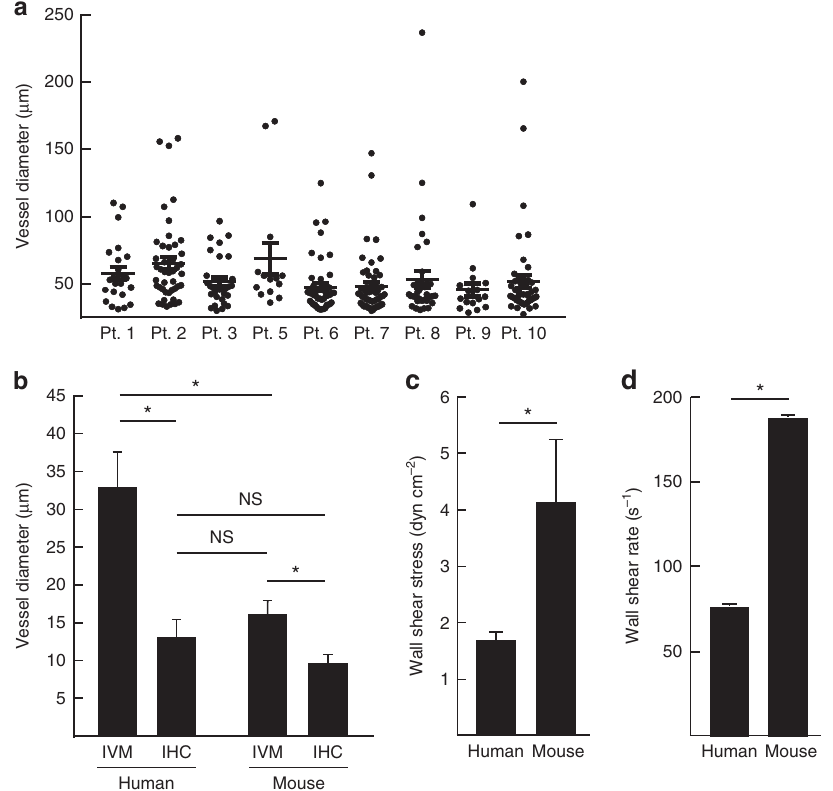
Figure 3 | Comparison of tumour vessel diameters by different methodologies. ( a ) Individual measurements of tumour vessel diameters in patients. ( b ) Tumour vessel diameters quantified by human IVM and IHC of the same tumour tissue and murine melanoma tumours demonstrate consistently larger diameters detected by IVM. Established methods of estimating human tumour vessel diameters by IHC or mouse IVM produce similar measurements that both significantly underestimate diameters measured by human IVM. ( c ) The wall shear stress in tumour vessels is larger in murine tumours when compared with patient tumours. ( d ) Wall shear rate is lower in patient tumour in comparison to patient tumours. ( a – d ) * P o 0.05l; NS, non significant (unpaired Student’s t -test). n ¼ 9 for patients; n ¼ 10 for mice. Data is mean ±